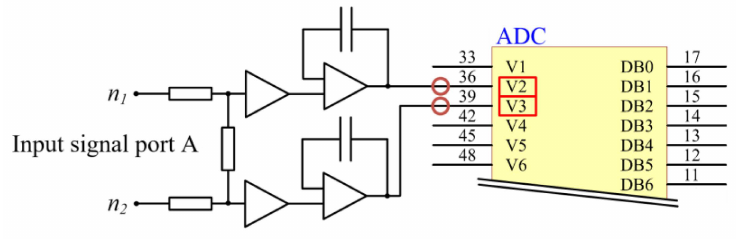
Figure 10. Schematic diagram of the pin test points of the analog-to-digital converter (ADC) signal input terminal.